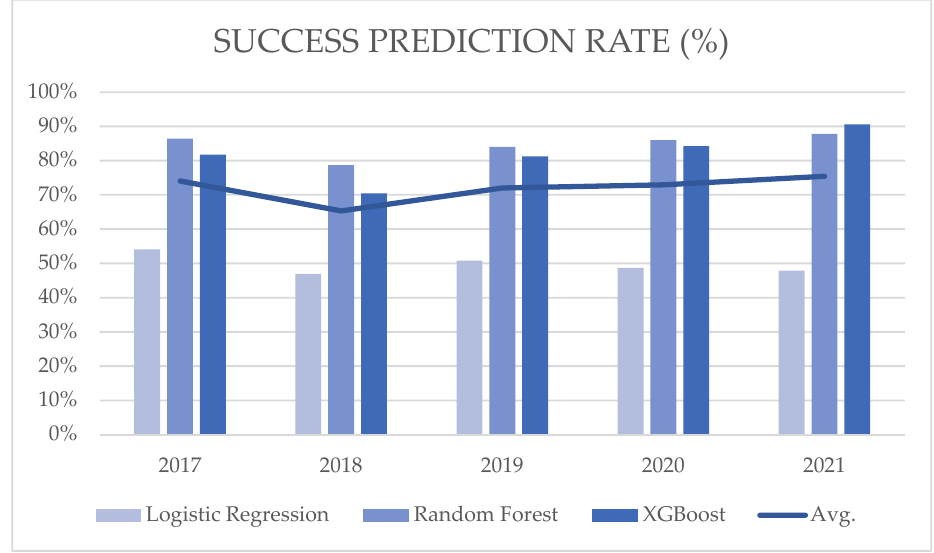
Figure 5. Stock selection performance (success prediction rate).